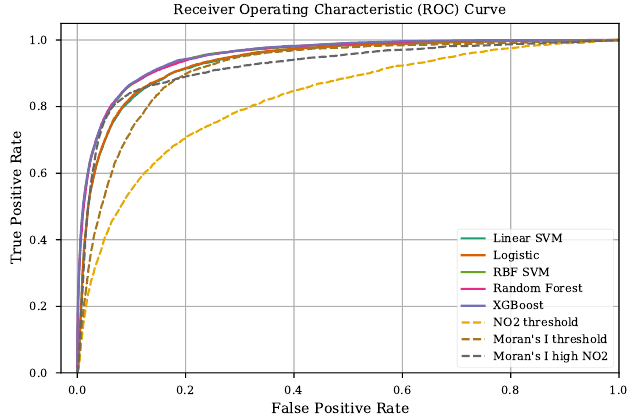
Figure 12. Receiver Operating Characteristic (ROC) curve based on five-fold cross-validation. Dashed lines indicate the results obtained from univariate threshold-based methods that, in this study, we considered as